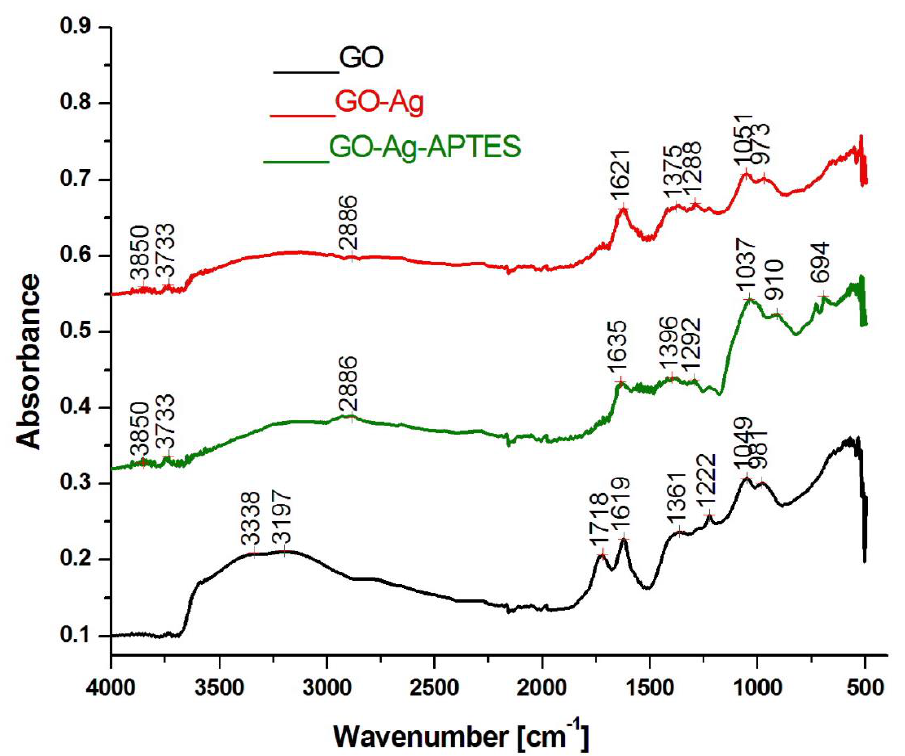
Figure 3. FT-IR spectra of graphene oxide (GO), graphene oxide with silver (GO-Ag) and silanized graphene oxide with silver (GO-Ag-APTES).